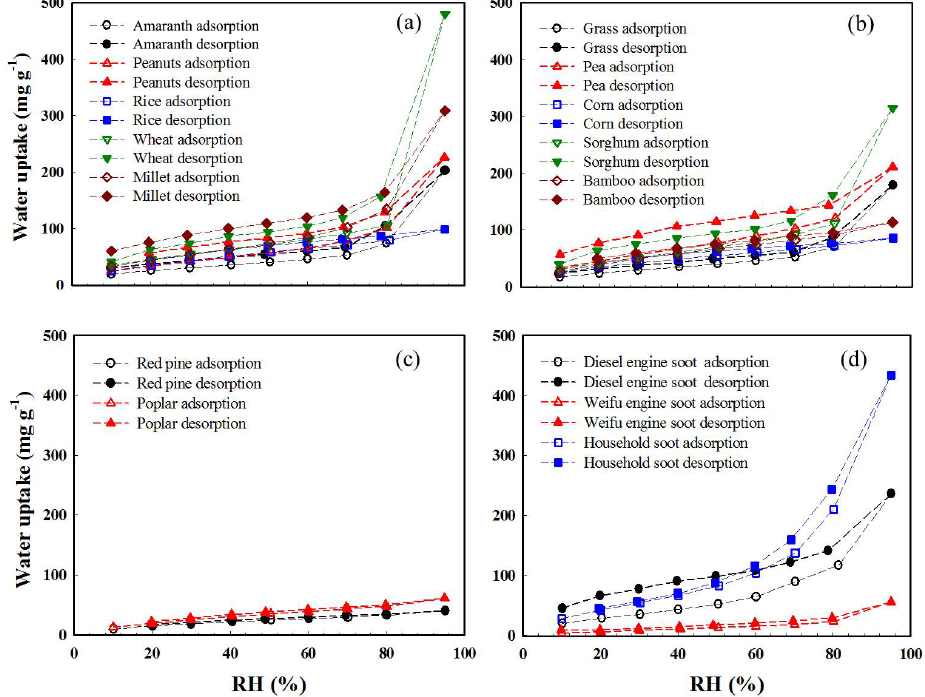
Figure 1. Sorption and desorption isotherms of water vapor plotted as water uptake (mgg − 1 ) vs. relative humidity (RH, %) at equilibrium for different BCPs. (a) Subgroup 1 of herbal BCPs. (b) Subgroup 2 of herbal BCPs. (c) Woody BCPs. (d) Soot. Data were collected from single-point